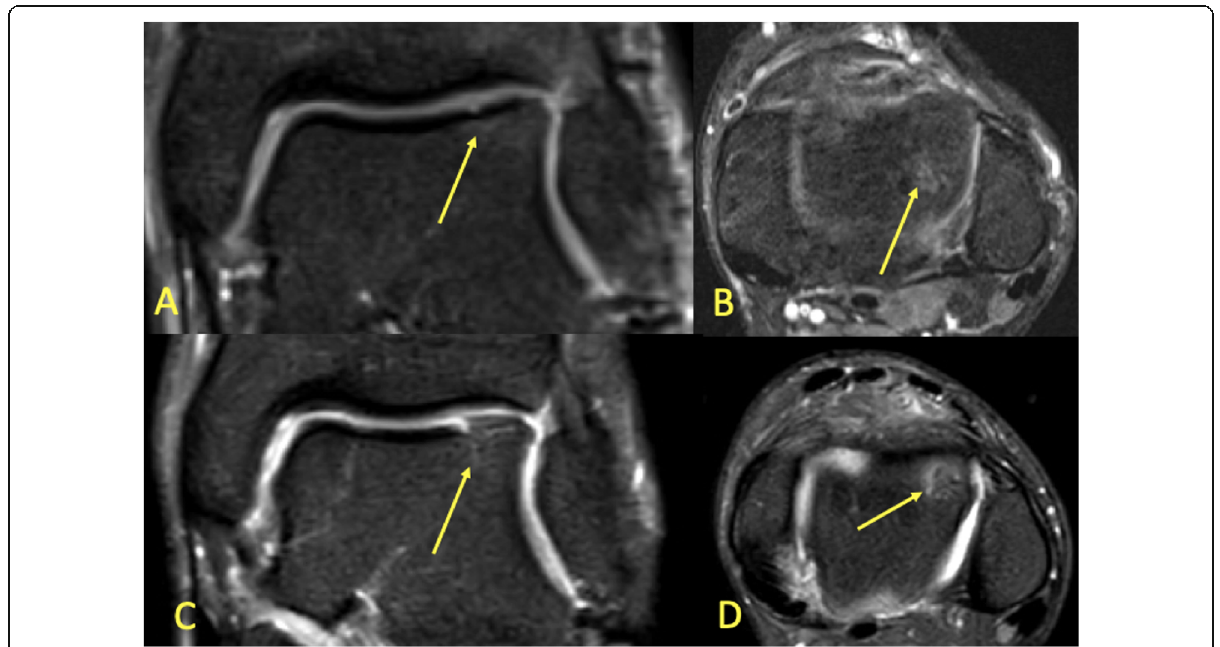
Fig. 17 A 19-year-old handball player with 3-month history of ankle pain imaged for suspected anterior tibiofibular ligament rupture and stress fracture. a , b On the initial MRI, the cartilage lesion (arrow) was missed, and neither an anterior tibiofibular ligament rupture nor a stress fracture was detected. c , d Because of persistent pain preventing training, MRI was repeated after 8 months. A chondral lesion with subchondral BME was visible and could be identified retrospectively on the previous MRI (arrows)